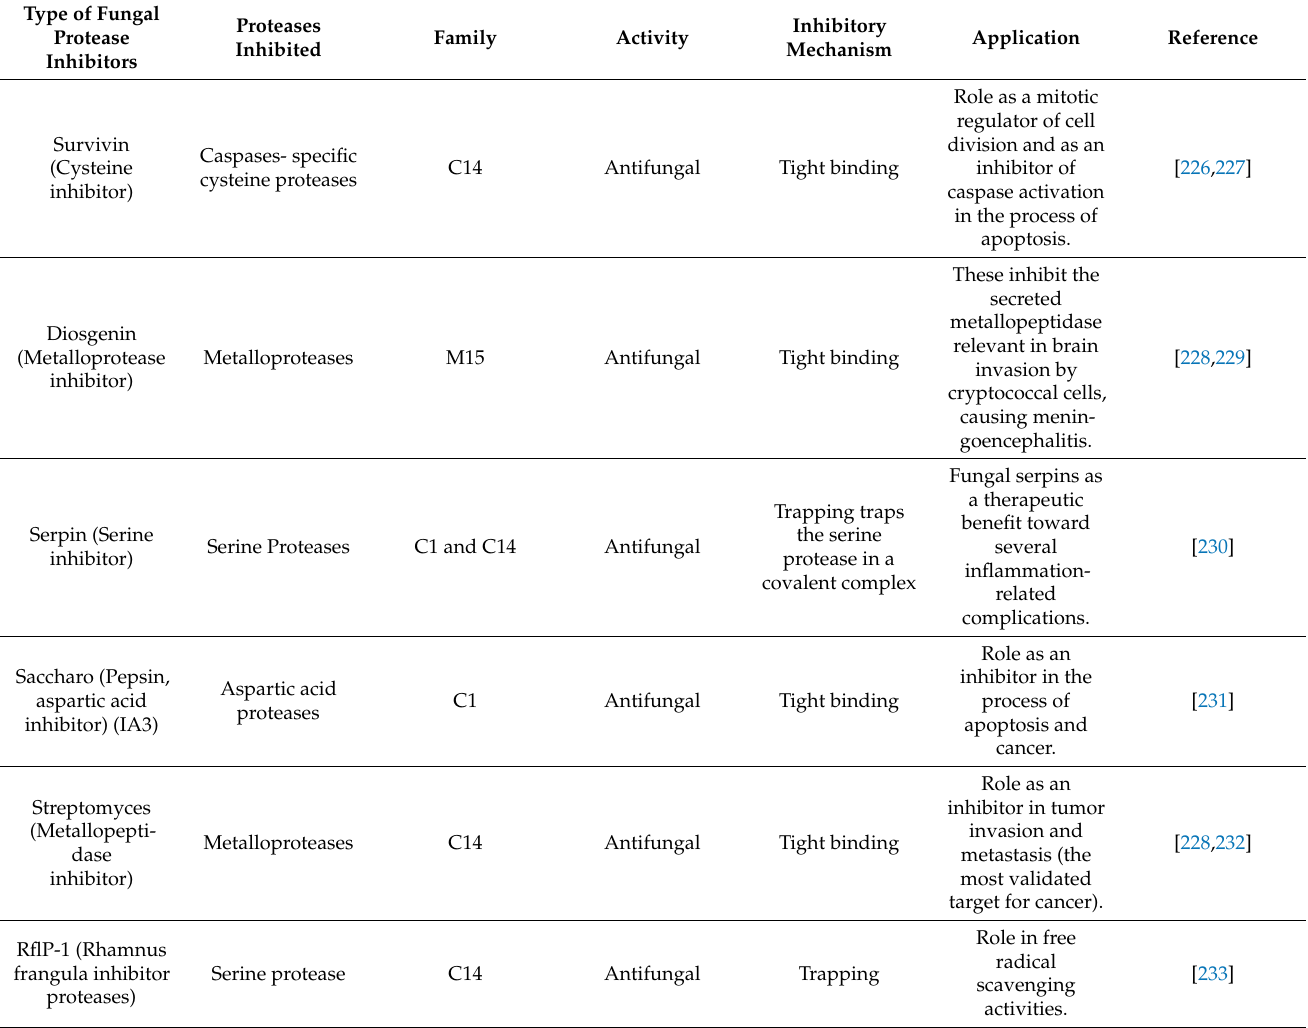
Table 5. Fungal protease inhibitors for biomedical